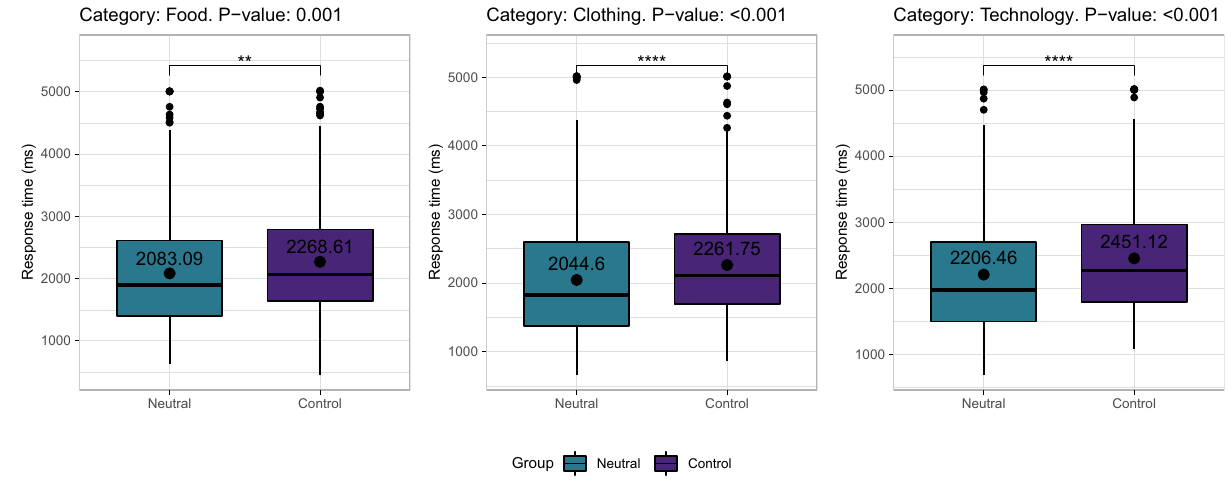
Figure 1. Response time differences between control participants and participants exposed to the neutral